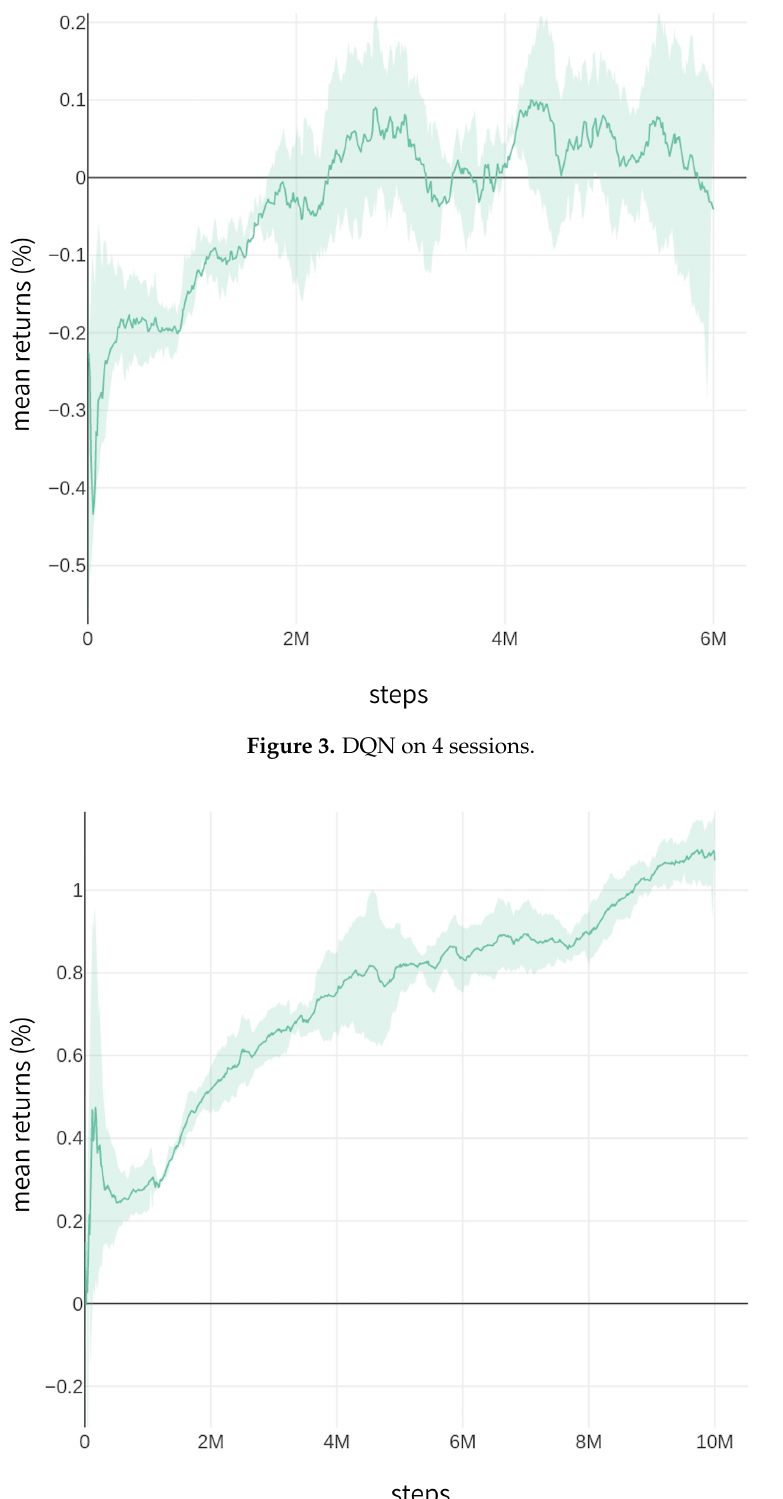
Figure 4. PPO on 4